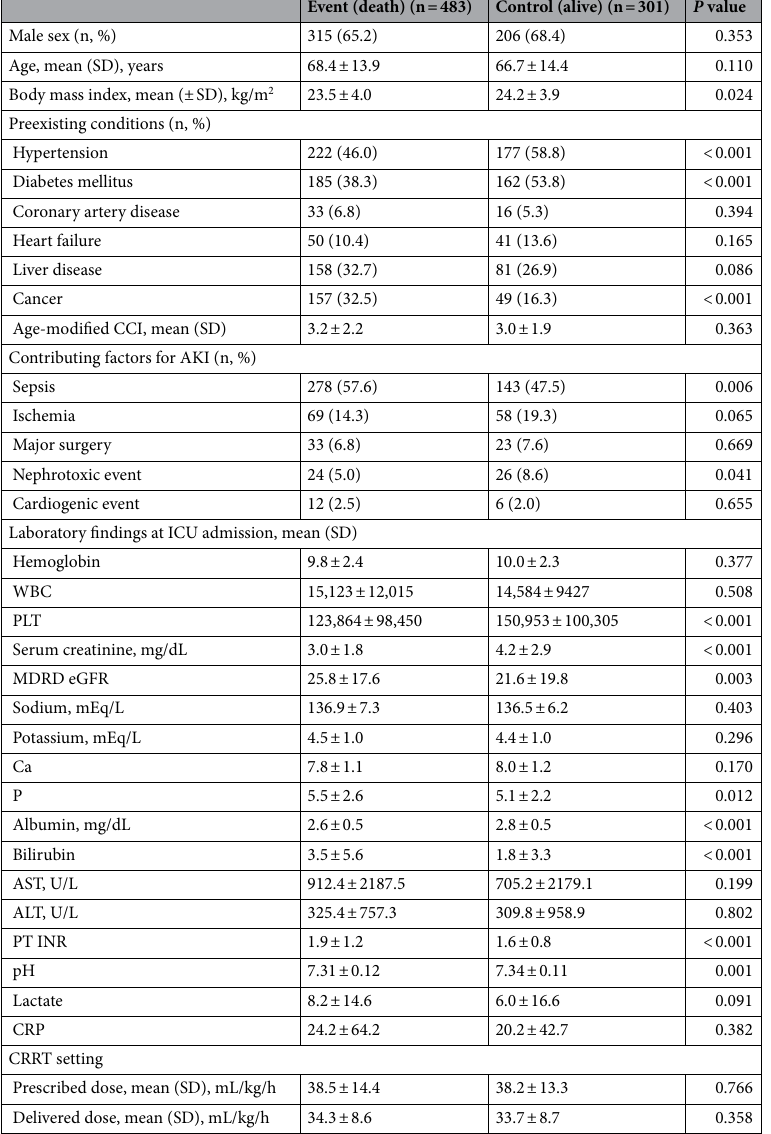
Table 1. Patient baseline characteristics at the time of CRRT initiation. Continuous variables are presented as means (standard deviations) and categorical variables as frequencies (percentages). SD standard deviation,